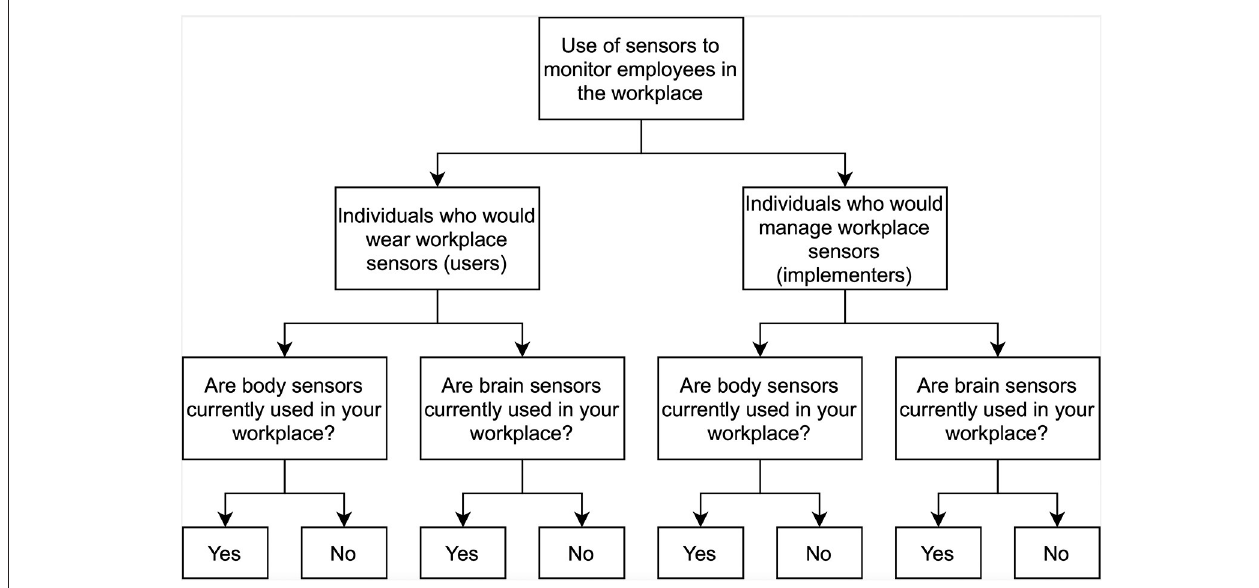
FIGURE 1 | Survey branching